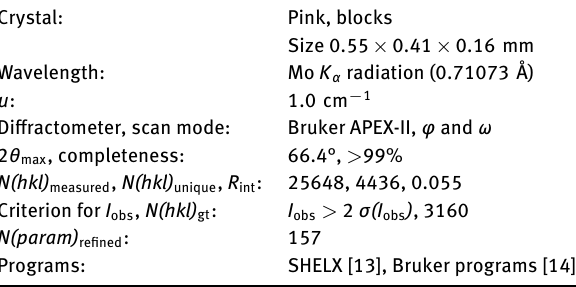
Table 1: Data collection and